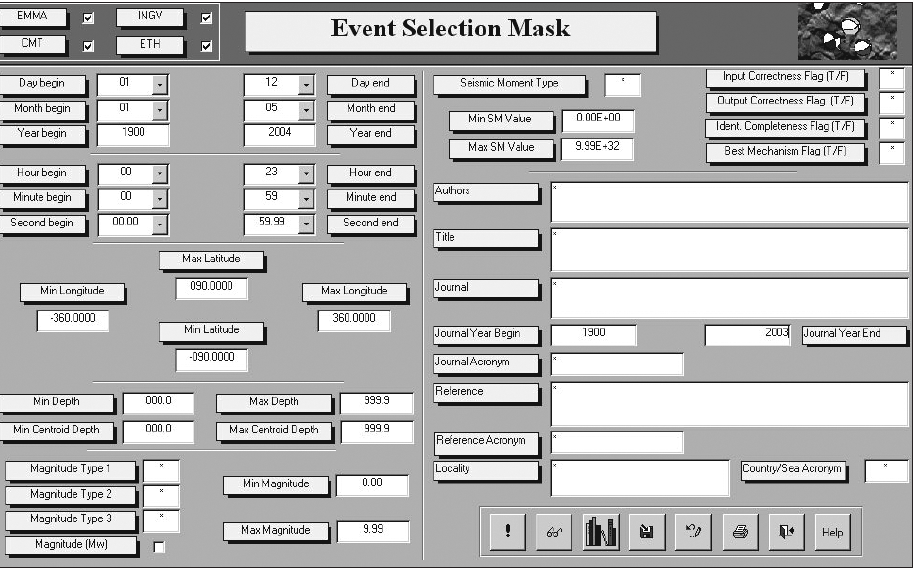
Fig. 5. Mechanism Selection